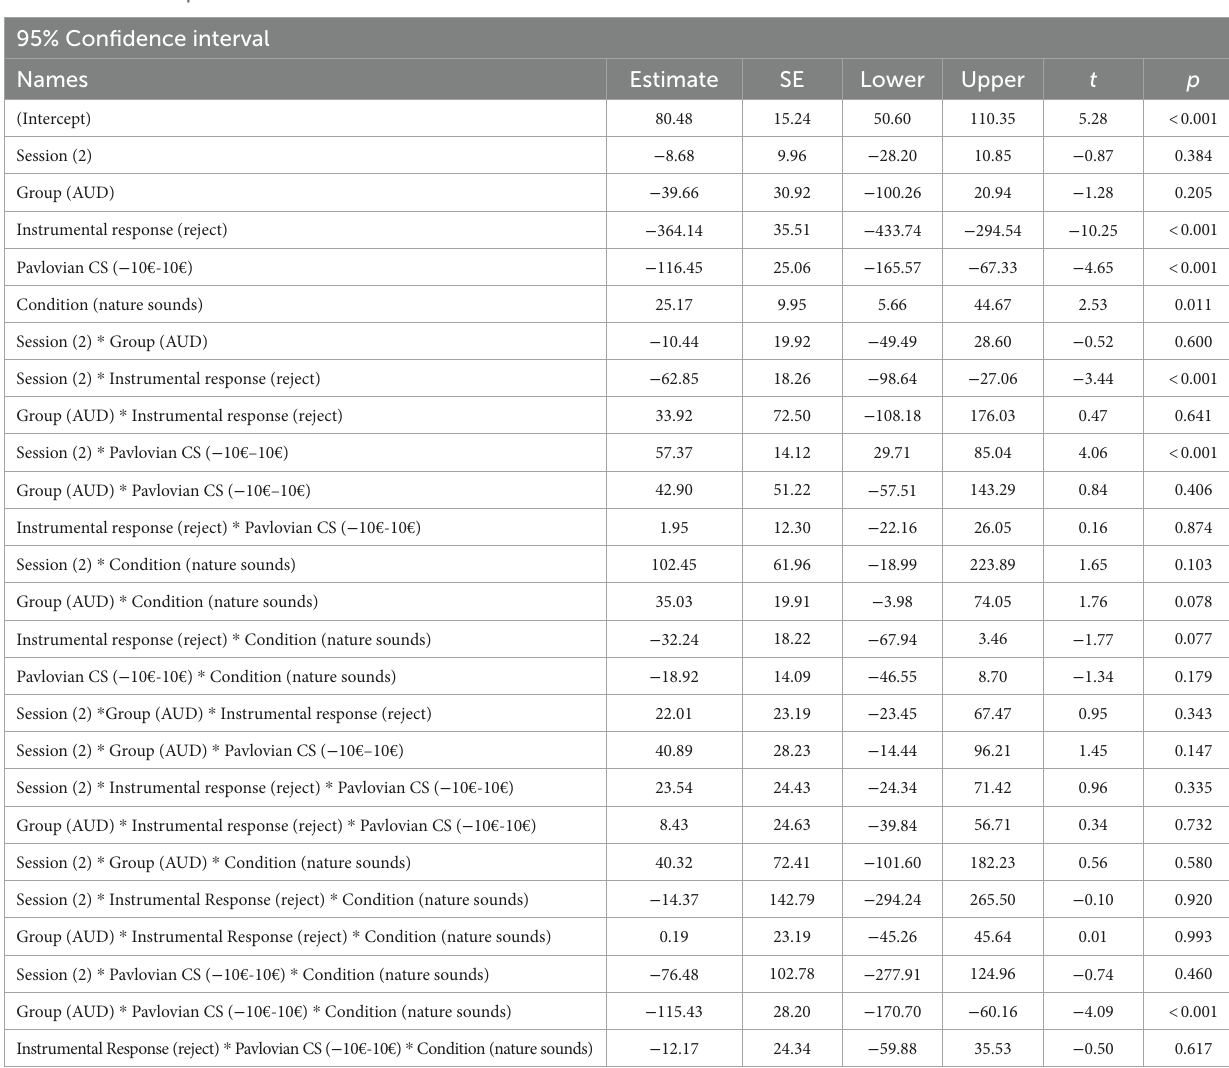
TABLE 3 Fixed effects parameter estimates. 95% Confidence